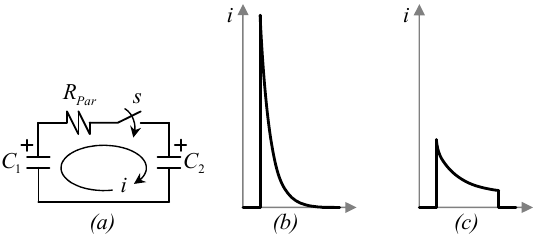
Figure 17. Basic non-resonant SC circuit, ( a ) schematic, ( b ) current between capacitors with full charge interchange, ( c ) current between capacitors with a partial charge interchange.